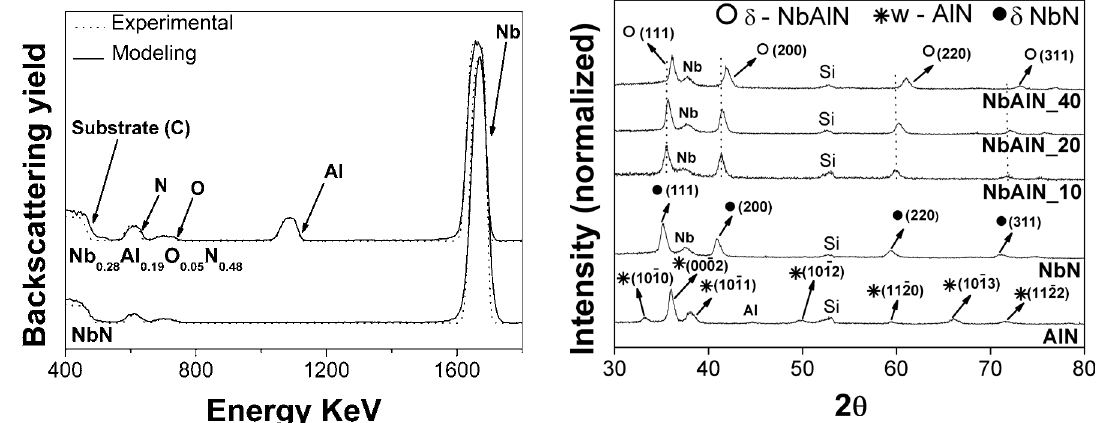
Figure 2. XRD patterns for AlN, NbN and Nb Al O N samples. 0.28 0.19 0.05 0.48 deposited. related to the substitution of Nb by Al atoms, since aluminum possess a smaller ionic radius compared to niobium, 0.54 Å and 0.72 Å, respectively 18